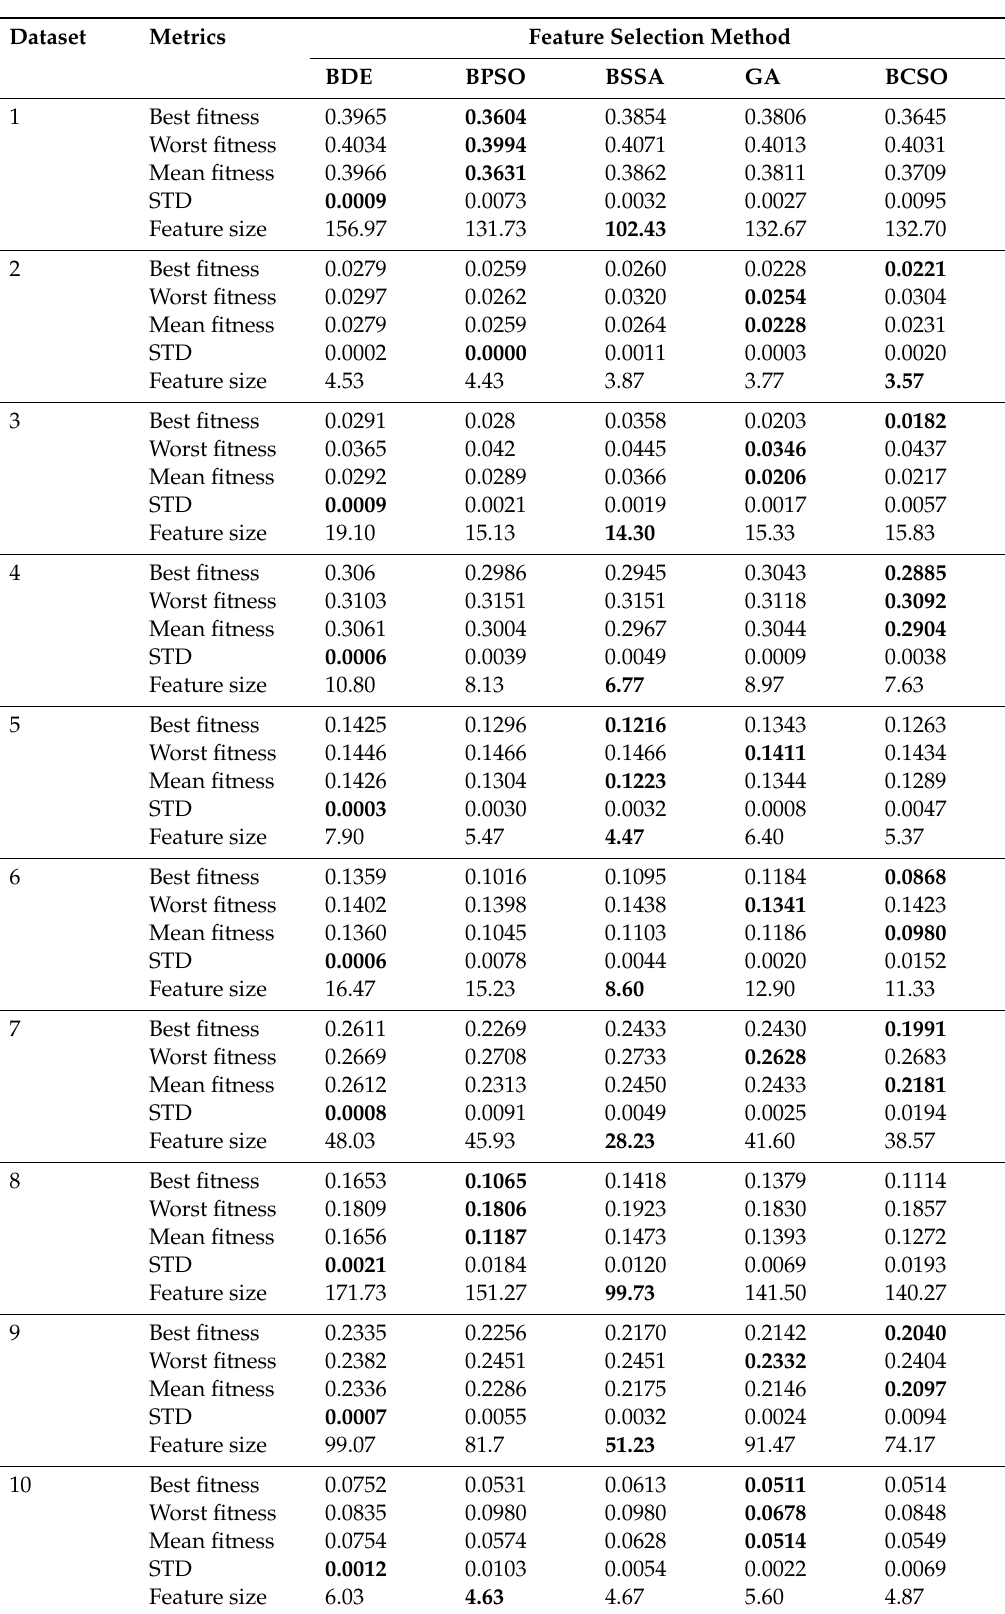
Table 4. Comparison of the results of BCSO with BDE, BPSO, BSSA, and